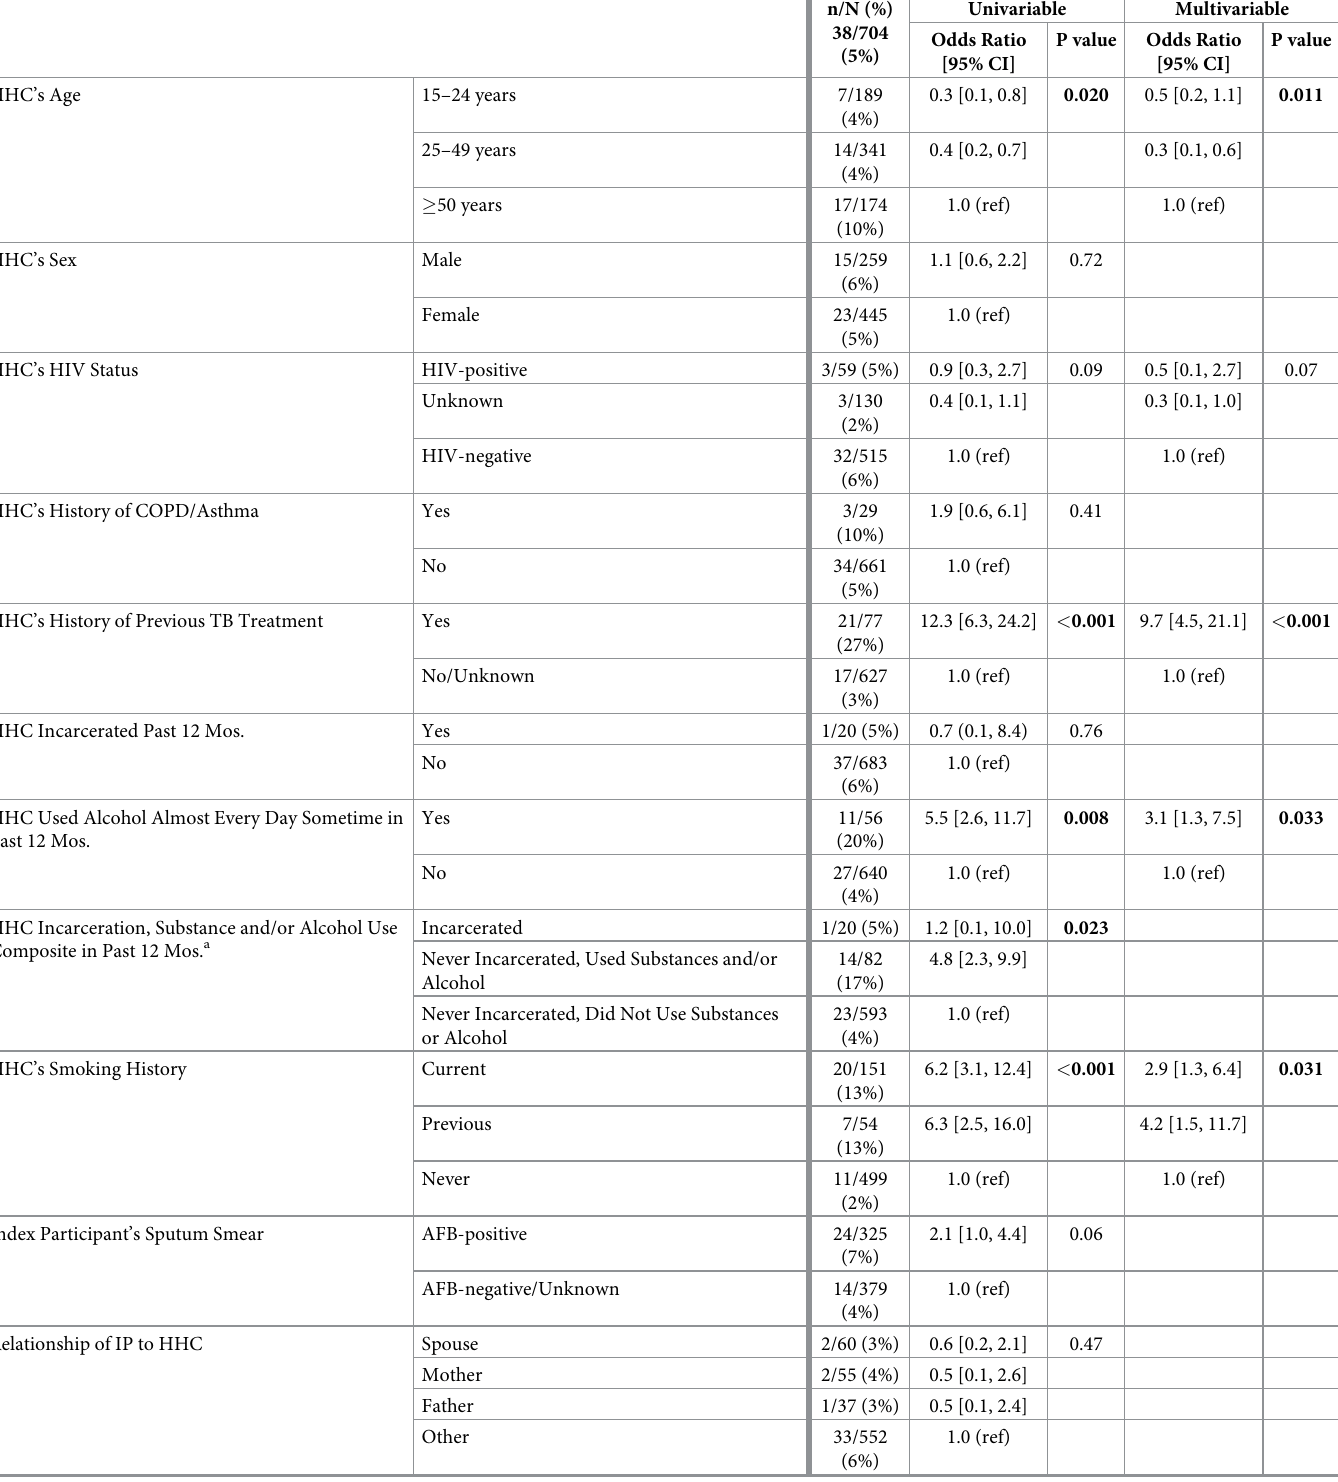
Table 3. Logistic regression modeling for confirmed or probable TB disease in household contacts � 15 years of age �